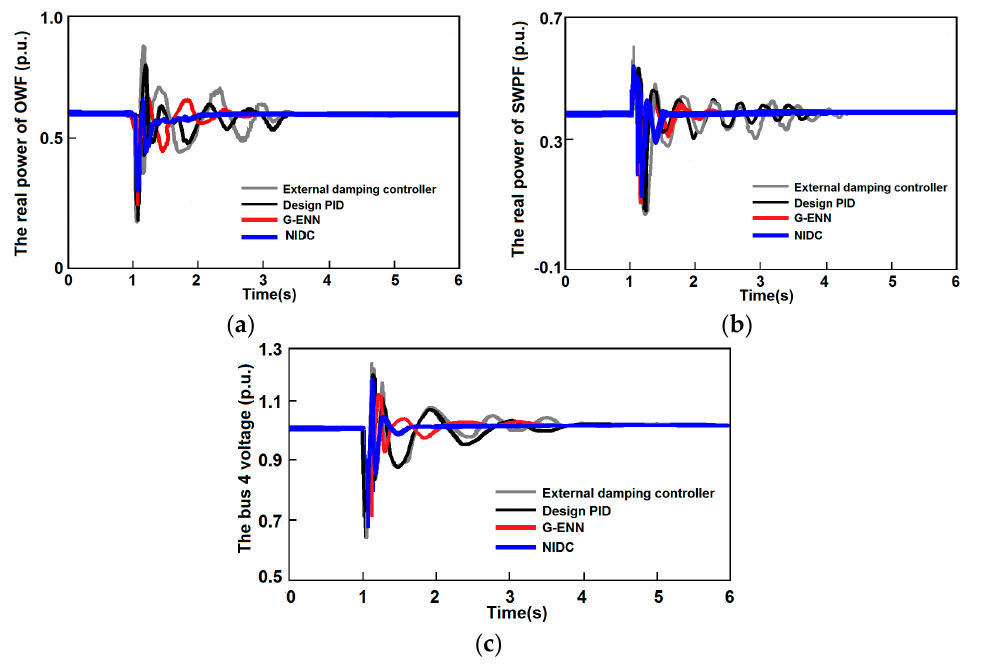
Figure 10. The responses of transient stability for Case 2 ( a ) The real power of OWF; ( b ) The real power of SWPF; ( c ) The voltage of bus 4.